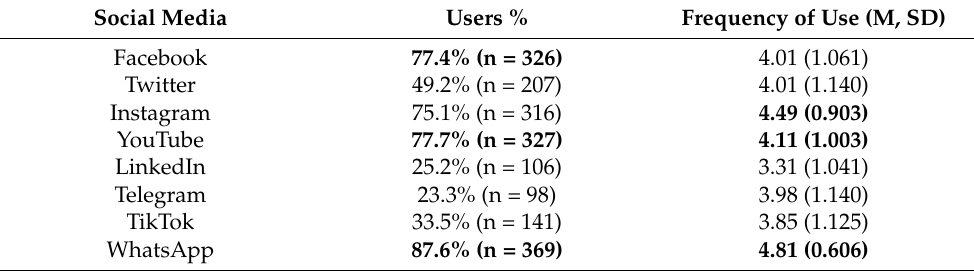
Table 1. Most used social